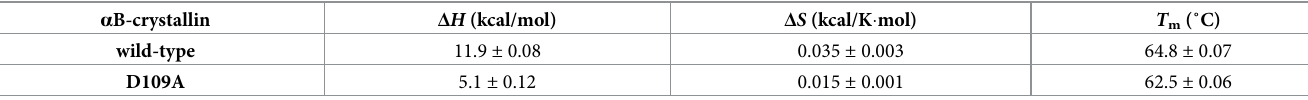
Table 4. Thermodynamic parameters of α B-crystallin protein samples by DSC assessment. α